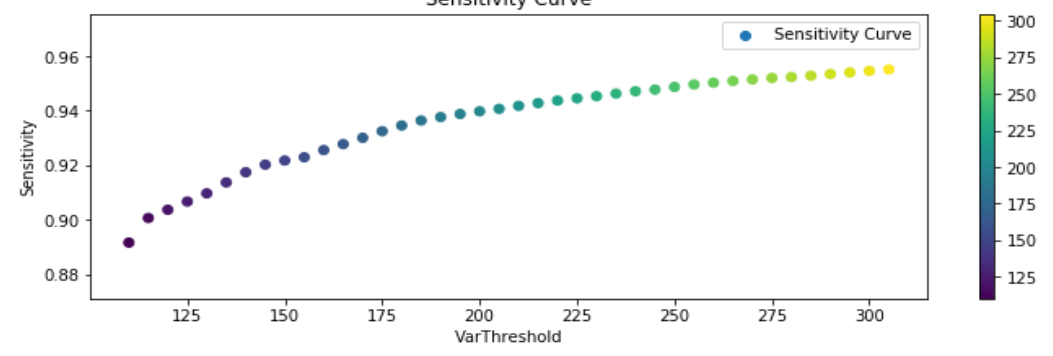
Figure 15. Sensitivity TP/(TP + False Negative (FN)) results.